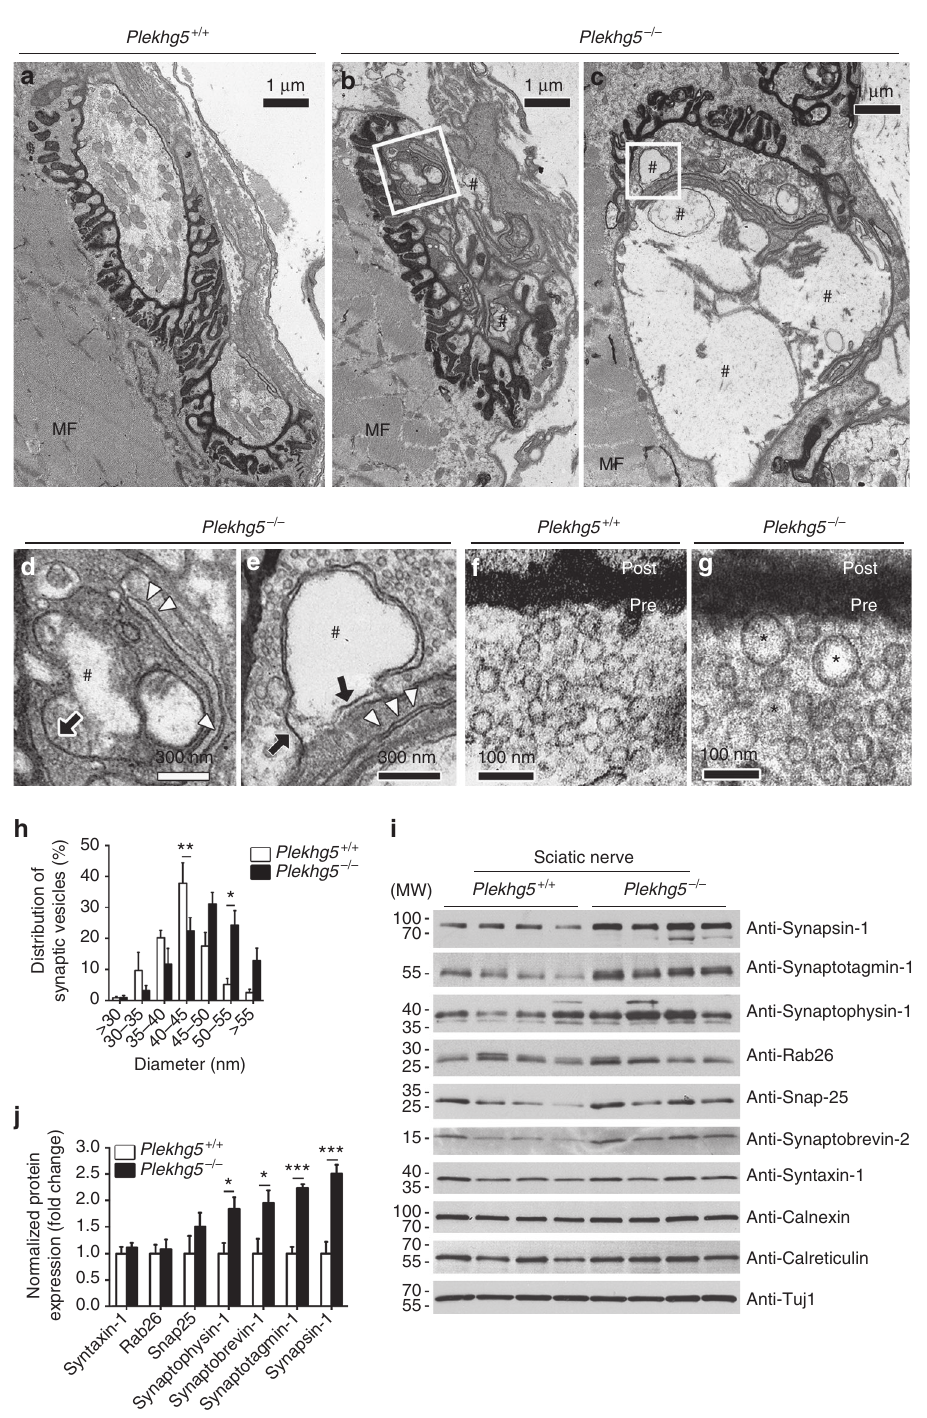
Fig. 3 Structural alterations and accumulation of synaptic vesicle proteins in Plekhg5-de fi cient mice. a – c Neuromuscular junction of Plekhg5 + / + a and Plekhg5 − / − b , c mice. # labels empty inclusions. MF myo fi bers. Scale bar : 1 µ m. d Membrane fragments in nerve terminals of Plekhg5-de fi cient mice. Scale bar : 300 nm. e Double membrane fragment forming an inclusion. Arrow points to single membrane. Arrowheads point to double